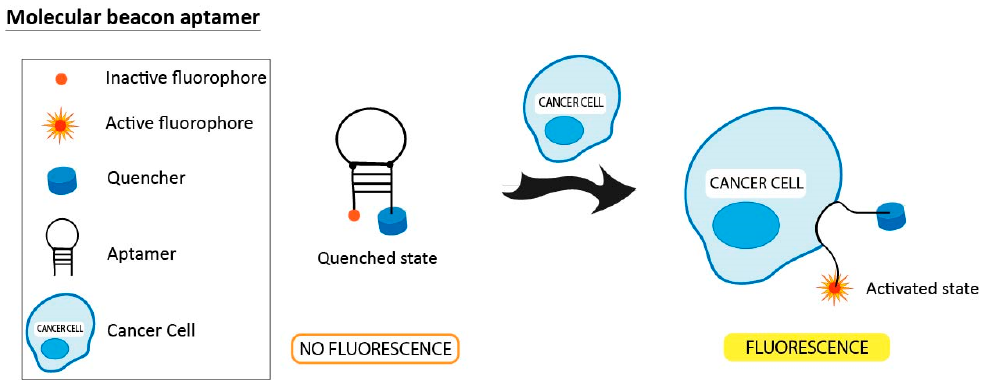
Figure 6. Molecular beacon aptamers (MB-Apt) for cancer cell detection with fluorophore and quencher at the 5 ′ - and 3 ′ -ends of the aptamer, respectively. In the absence of a target, the hairpin structure of the MB-Apt holds the quencher molecule close to the fluorophore, resulting in no fluorescence emission. When the MB-Apt is bound to membrane receptors of the cancer cell, its conformation is altered, thus resulting in an activated fluorescence signal because of fluorophore- quencher physical separation.